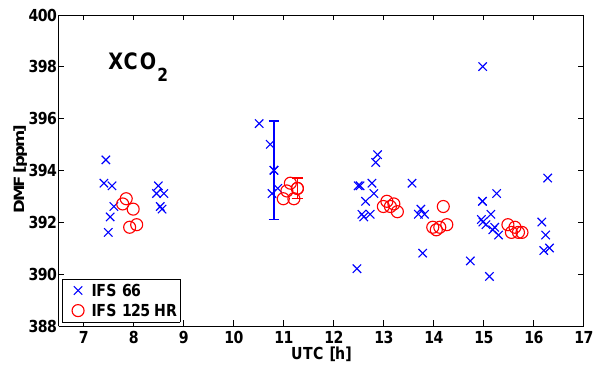
Fig. 6. Daily averages of XCO 2 , as measured by the IFS66 and the IFS125HR. The daily means are calculated from single measure- ments as a weighted mean, weighted to the reciprocal of their error variance. As example typical error bars of one σ are shown.